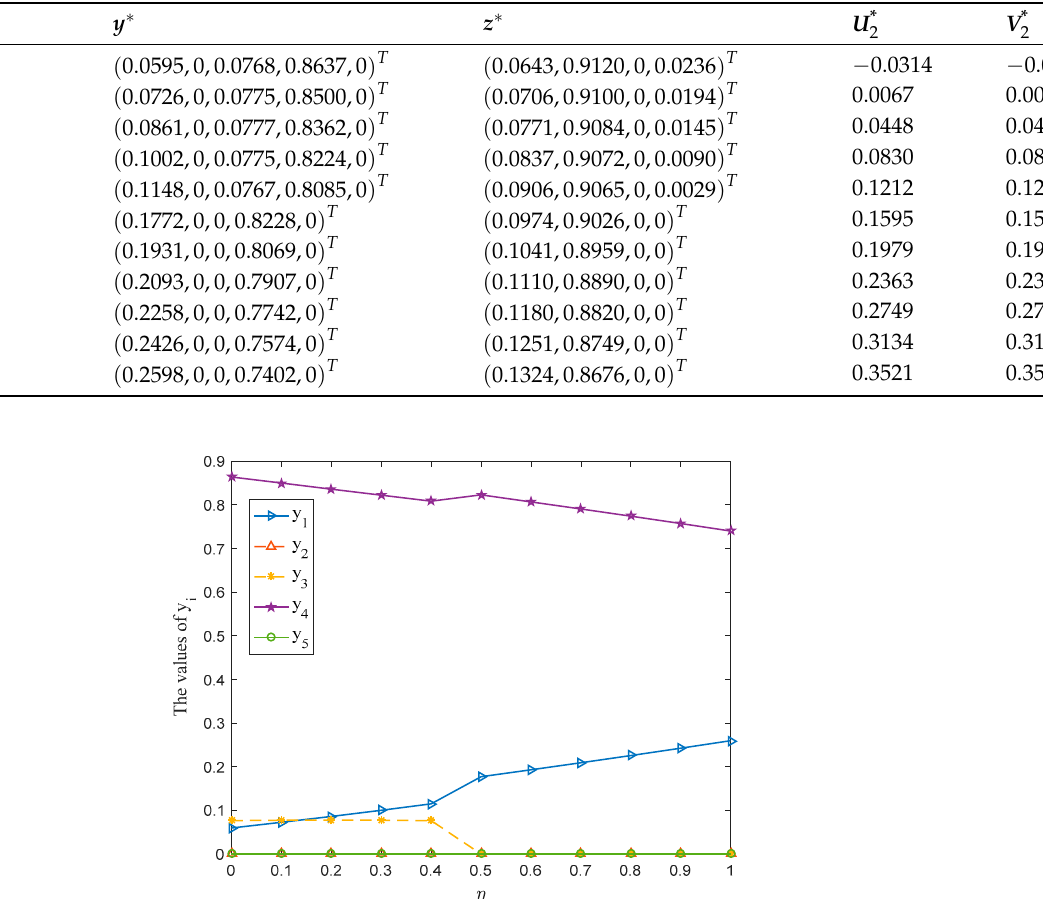
Table 3. Results obtained by using triangular fuzzy envelope for different values of η .